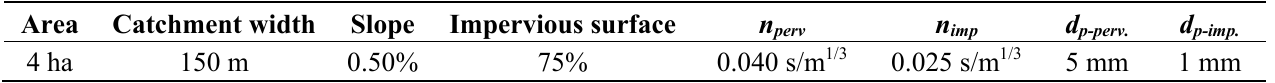
Table 1. Characteristics of the virtual catchment analyzed.